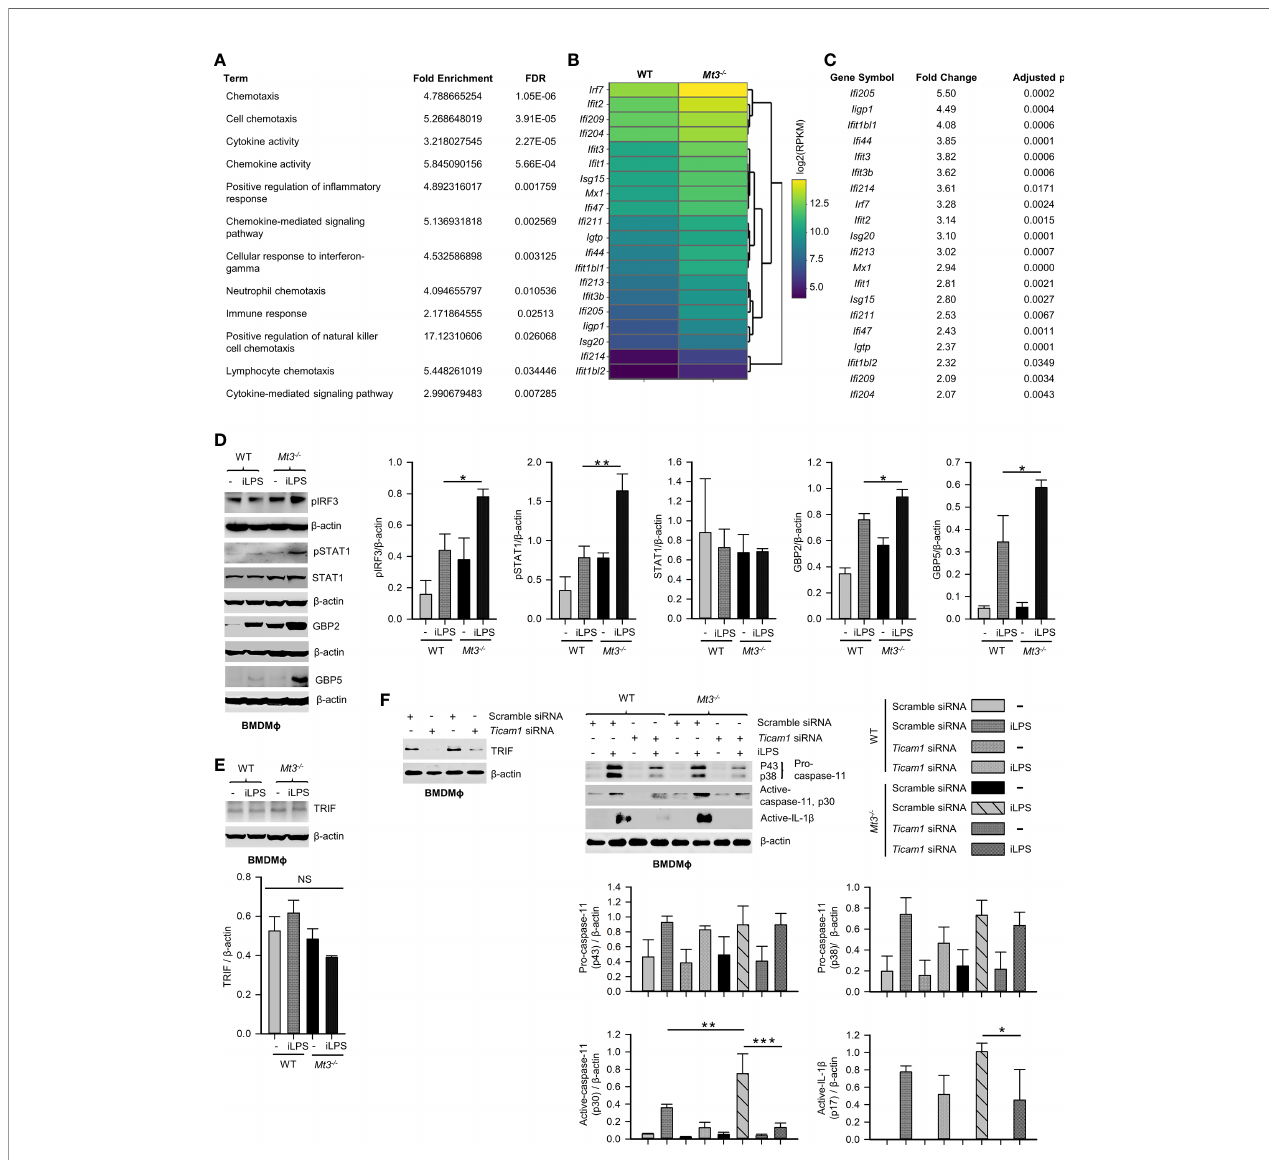
FIGURE 5 | See also Supplementary Figure S5 MT3 thwarts TRIF-IRF3-STAT1 signaling to suppress non-canonical in fl ammasome activation. (A) Functional enrichment analysis of differentially expressed genes using RNA-seq data from resting WT and Mt3 -/- BMDM f (NCBI SRA: PRJNA533616) (19) FDR, false detection rates. (B, C) Heat map (left) and table (right) show differentially expressed IFN-related genes in resting Mt3 -/- BMDM f compared to resting WT BMDM f obtained from RNA-seq analysis. (D) Western blots of pIRF3, pSTAT1, STAT1, GBP2 and GBP5 in vehicle or iLPS (10 m g/ml)-treated WT and Mt3 -/- BMDM f lysates, 3-4 independent experiments, one-way ANOVA. (E) Western blots of TRIF in lysates from WT and Mt3 -/- BMDM f stimulated as above, 3 independent experiments, one-way ANOVA. (F) Scramble and Ticam1 siRNA treated WT and Mt3 -/- BMDM f treated with iLPS (10 m g/ml) or vehicle for 48h. Immunoblots of TRIF (2 independent experiments), pro-caspase-11, and active-caspase-11 in lysates and active-IL-1 b in supernatants, 3 independent experiments, one-way ANOVA, data are mean ± SEM. *p < 0.05, **p < 0.01, ***p < 0.001; NS, not signi fi